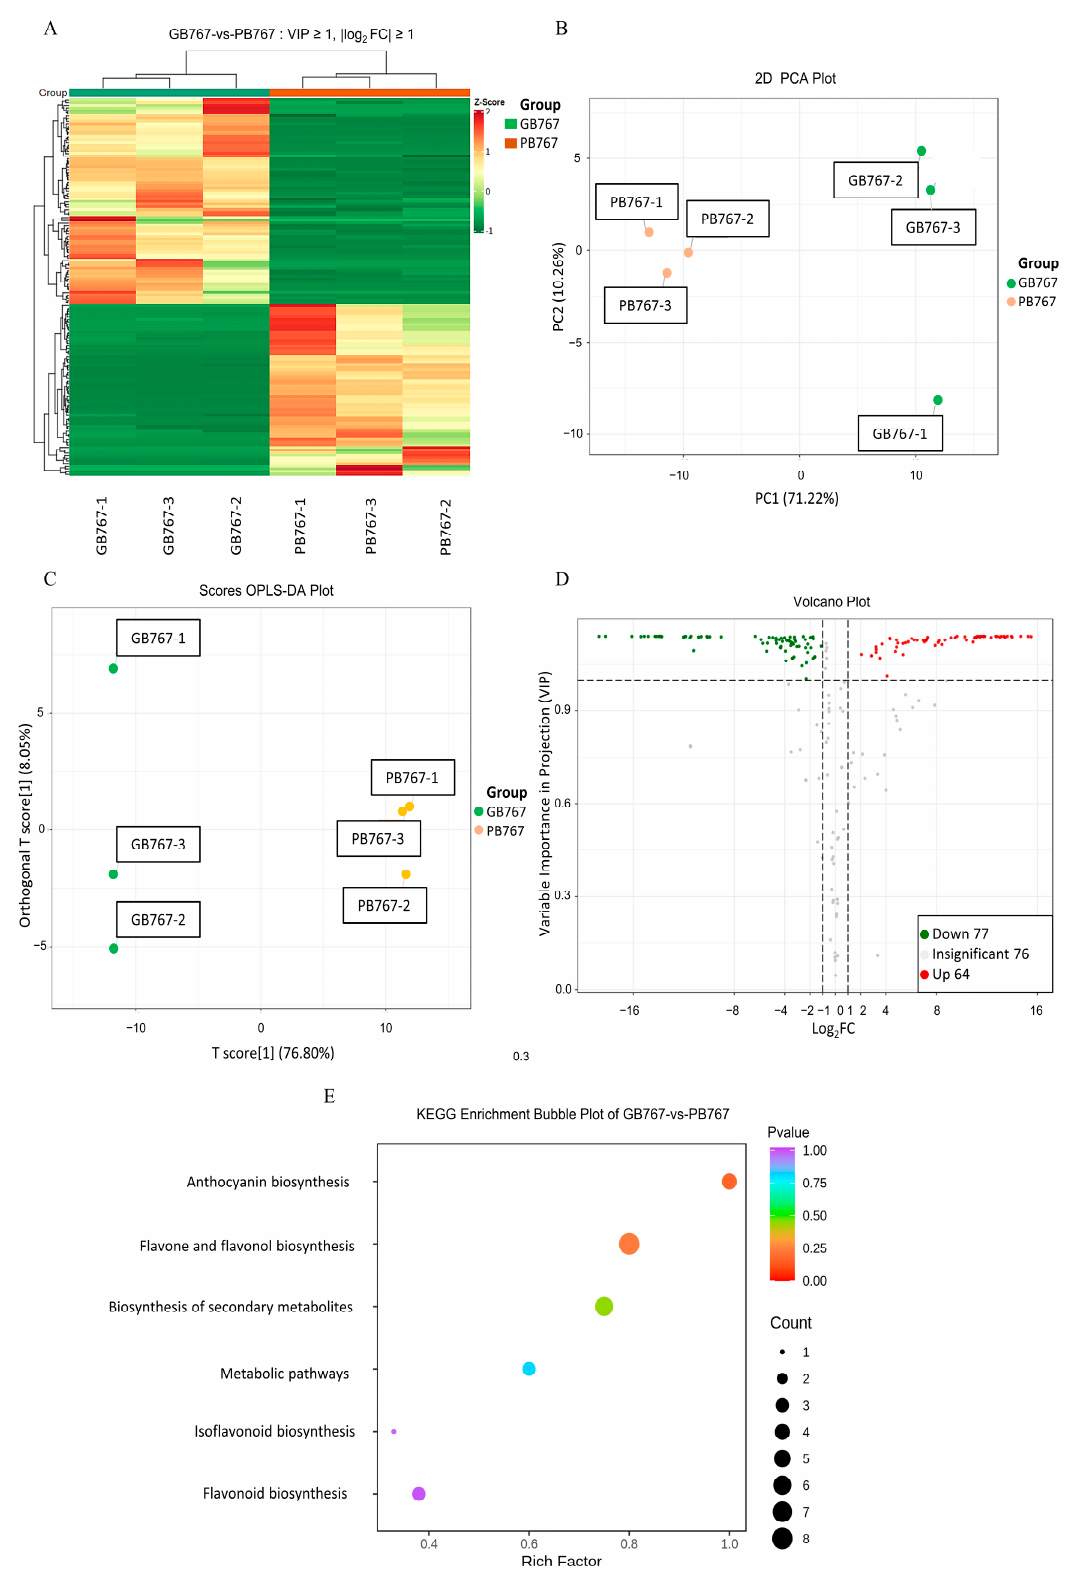
Figure 5. Identification and KEGG pathway enrichment analysis of DPMs in GB767 vs. PB767. ( A ) Heatmap and hierarchical clustering of DPMs. ( B ) PCA plot of the relative content of GB767 and PB767 metabolites. ( C ) OPLS-DA plot. ( D ) Volcano plot of upregulated and downregulated metabolites. ( E ) KEGG pathway enrichment bubble plot of DPMs.